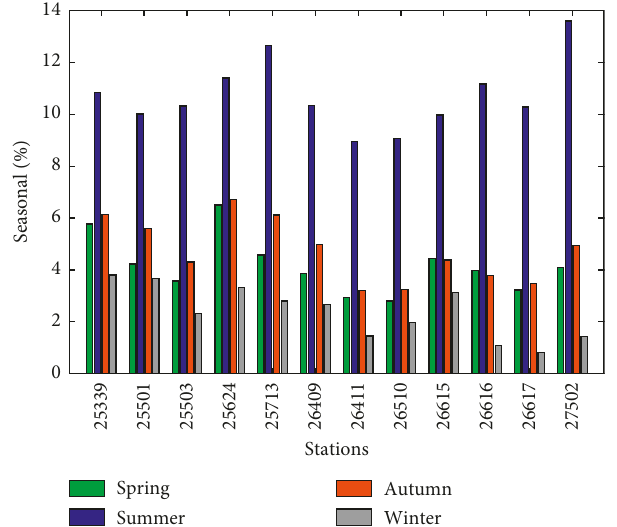
Figure 7: Seasonal (spring, summer, autumn, and winter) average probability (%) distributions of elevation ducts at 12 stations in